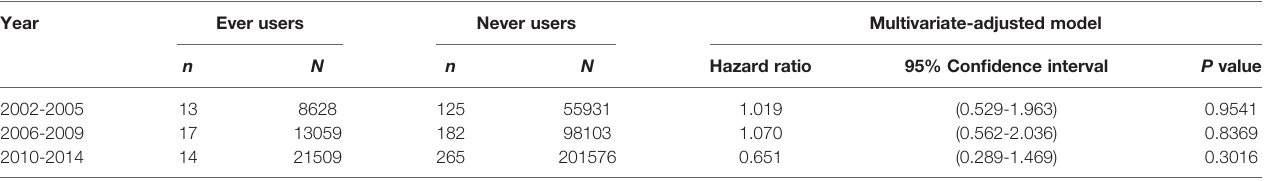
TABLE 3 | Incidence of dementia comparing ever versus never users of vildagliptin in patients enrolled during three different periods of time in the unmatched cohort. Year Ever users Never users Multivariate-adjusted